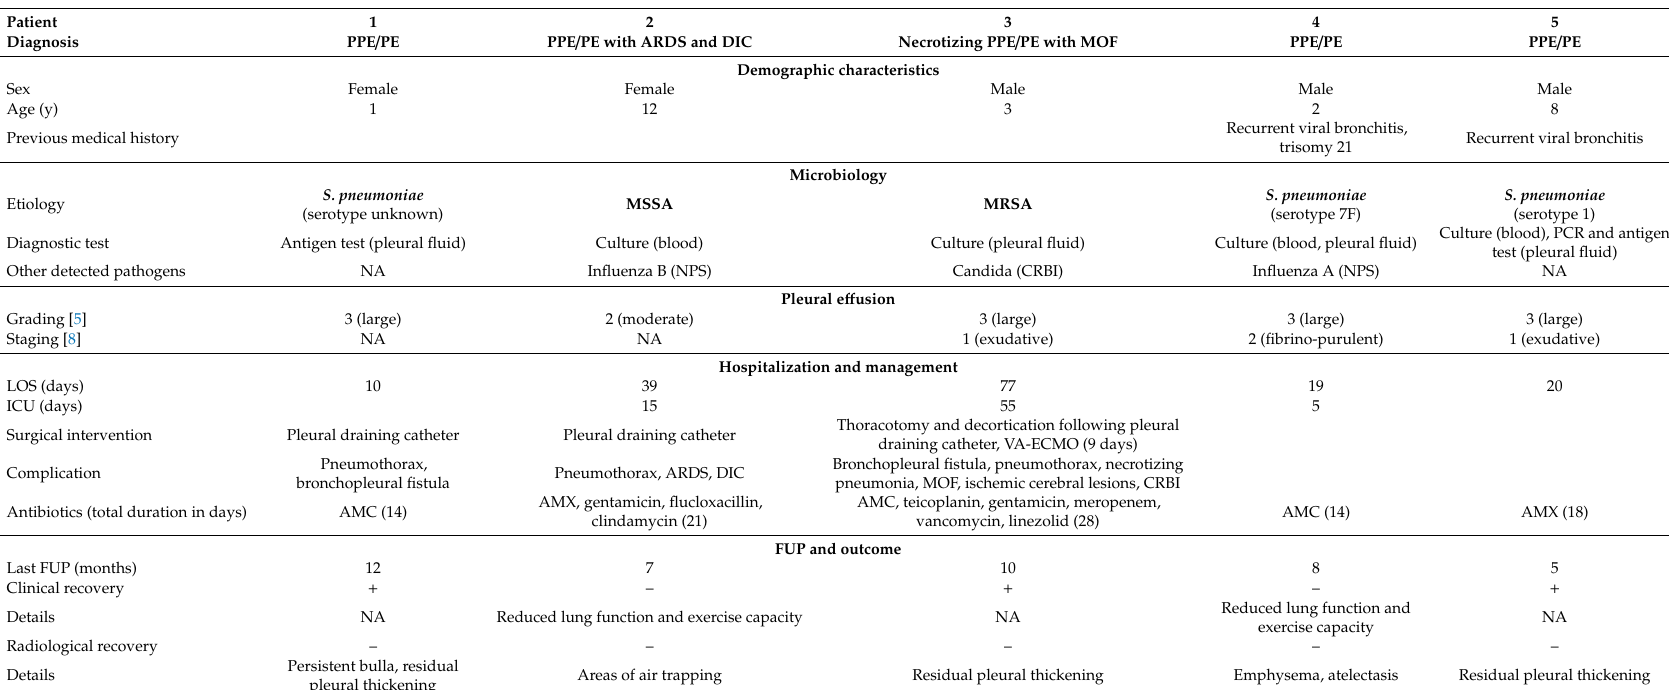
Table 4. Complications in children with PPE /